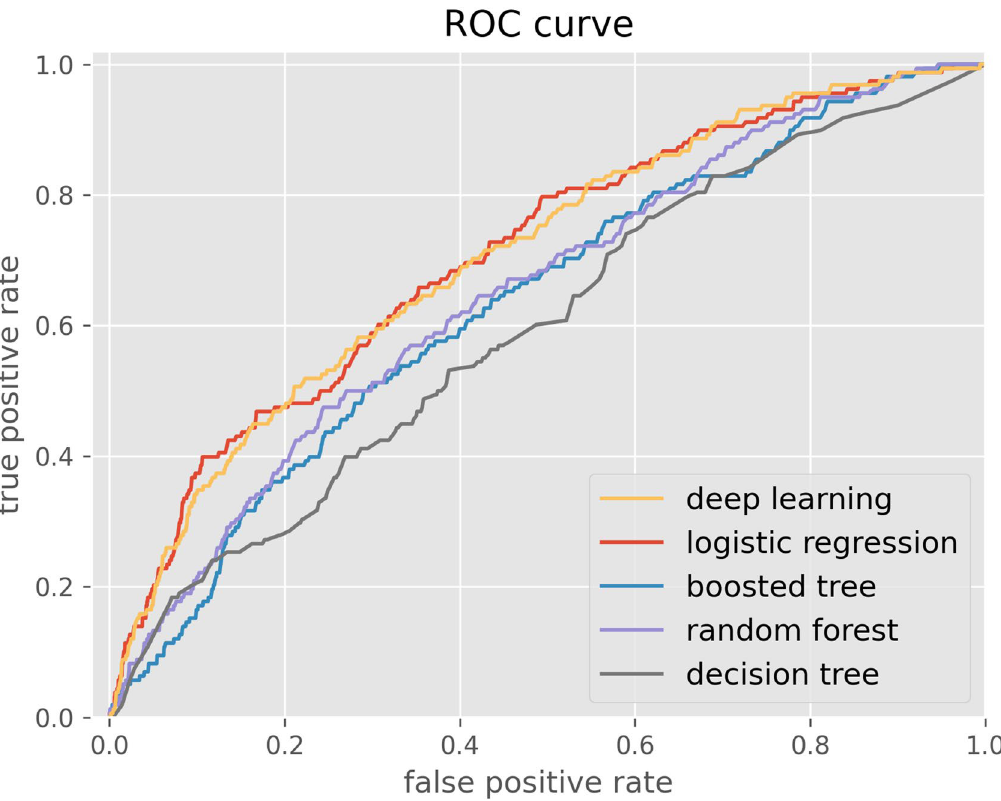
Figure 2. The ROC curves of the deep learning and four machine learning